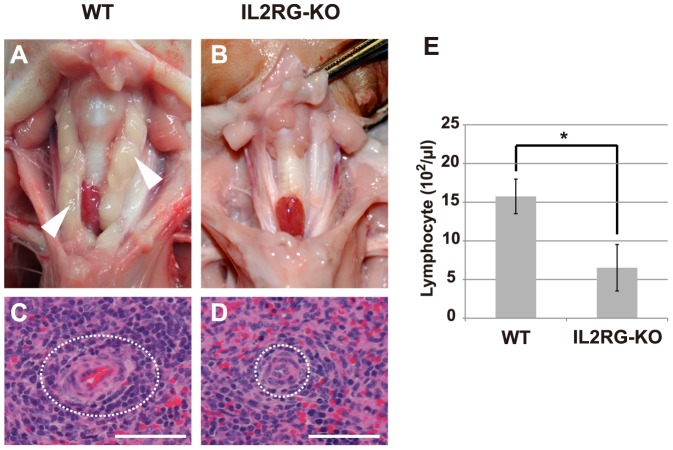
Phenotypes of IL2RG KO pigs.(A, B) The thymic phenotype in WT and IL2RG KO pigs. The white arrowheads indicate normal thymuses in WT pigs. (C, D) Histological analysis of the spleens of WT and IL2RG KO pigs. The white pulp of the spleen is indicated by a dotted white circle. Bar = 100 µm. (E) The proportion of lymphocytes in the peripheral blood (PB) of WT and IL2RG KO pigs. The data represent the means ± SD values for 4 pigs. The asterisk indicates a statistically significant difference (P<0.01) between the values for WT and IL2RG KO pigs (n = 4).